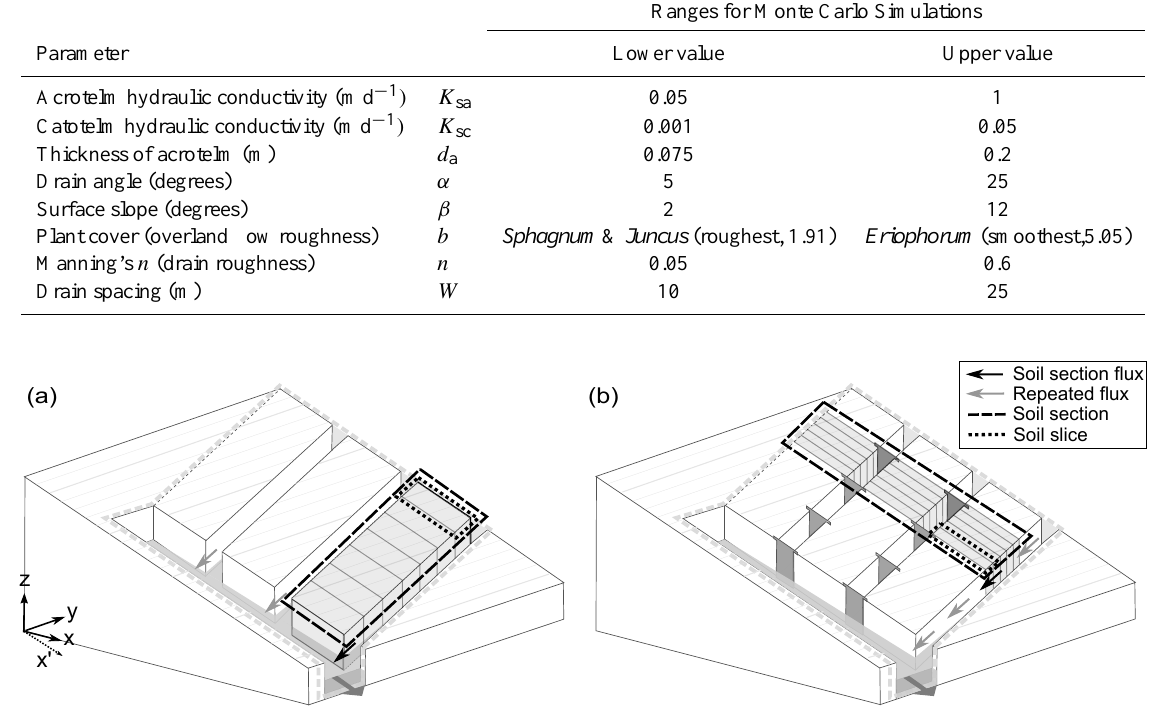
Fig. 2. Schematic of numerical representation of drained (a) and blocked drain (b) hillslope, demonstrating the concepts of soil sections and soil slices and the location of repeated